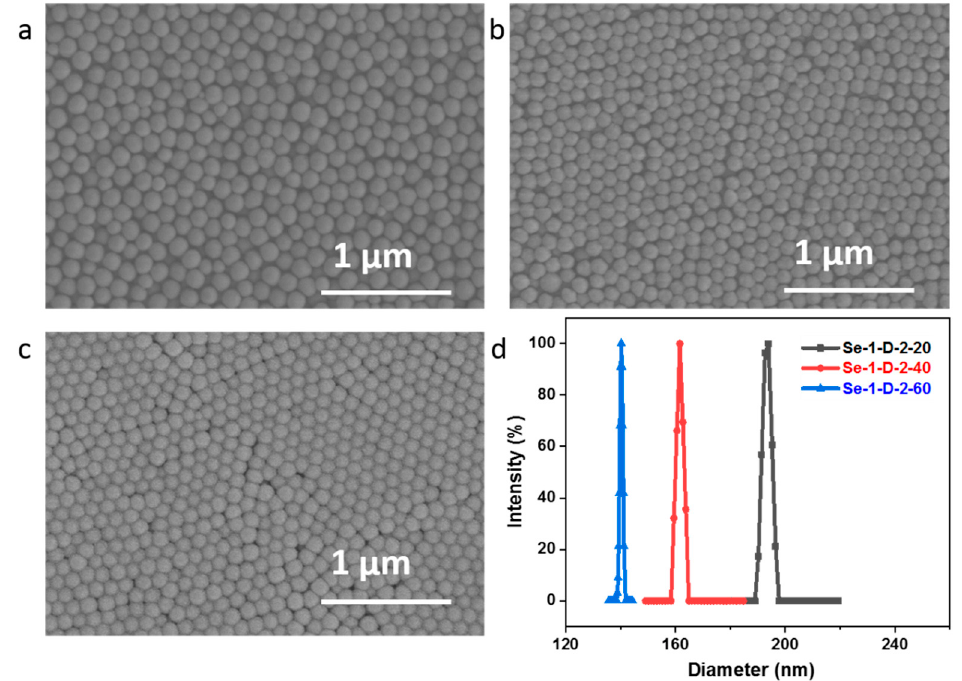
Figure 2. SEM images of DSe-PS. ( a ) Se-1-D-2-20, ( b ) Se-1-D-2-40, ( c ) Se-1-D-2-60. ( d ) Particle size distribution curve of DSe-PS microspheres, polydispersity indexes (PDI) were a = 0.1, b = 0.155, c = 0.013.